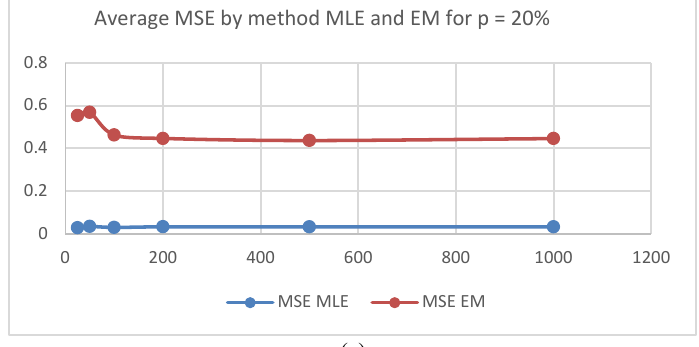
(c) Fig. 3 . Average MSE by method MLE and EM for the values of (a) p= 10%, (b) p=20% and(c) p=30%